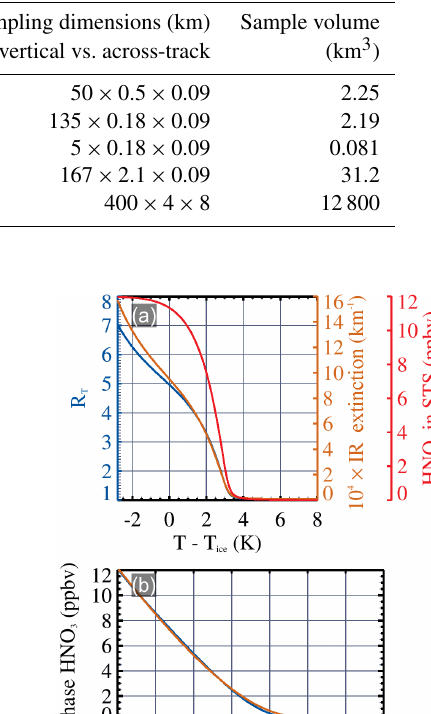
Table 1. Comparison of limb sounder and lidar sampling volumes.